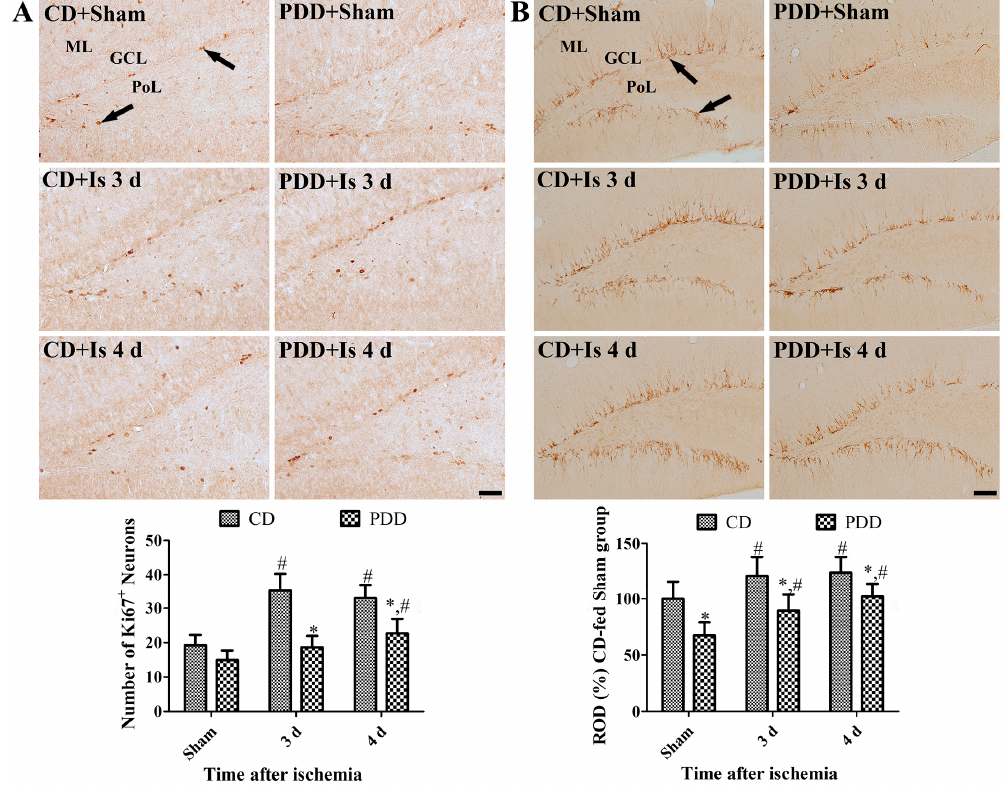
Figure 4. Immunohistochemical staining for Ki67 ( A ) and doublecortin (DCX) ( B ) in the dentate gyrus in the CD- and PDD-fed gerbils of sham- and ischemia-operated groups. Note that fewer proliferating Ki67-positive cells (arrows) and lower DCX immunoreactivity (arrows) are found in the PDD-fed gerbils than in the CD-fed ones. SO, stratum oriens; SP, stratum pyramidale; SR, stratum radiatum. Scale bar = 50 μ m ( A ) and 100 μ m ( B ). The number of Ki67-positive nuclei in the dentate gyrus and radiatum. Scale bar = 50 µ m ( A ) and 100 µ m ( B ). The number of Ki67-positive nuclei in the the ROD of DCX compared to the CD-fed sham group per section, in all the groups, are shown ( n = 7 per group; * p < 0.05, significant difference between CD- and PDD-fed group; # p < 0.05, significant difference between sham- and ischemia-operated groups). All data are expressed as mean with standard deviation.